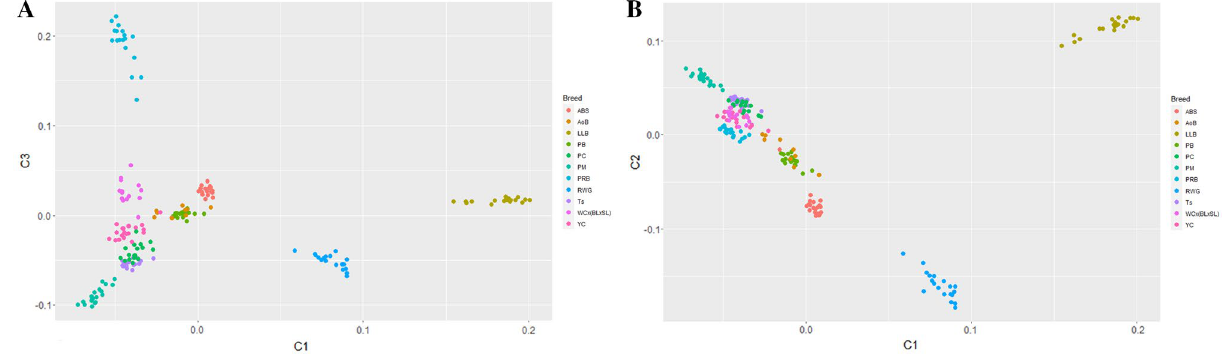
Figure 6. Results of PCA analysis of the 11 core chicken breeds. ( A ) First (C1) and third (C3) components. ( B ) First (C1) and second (C2) components.